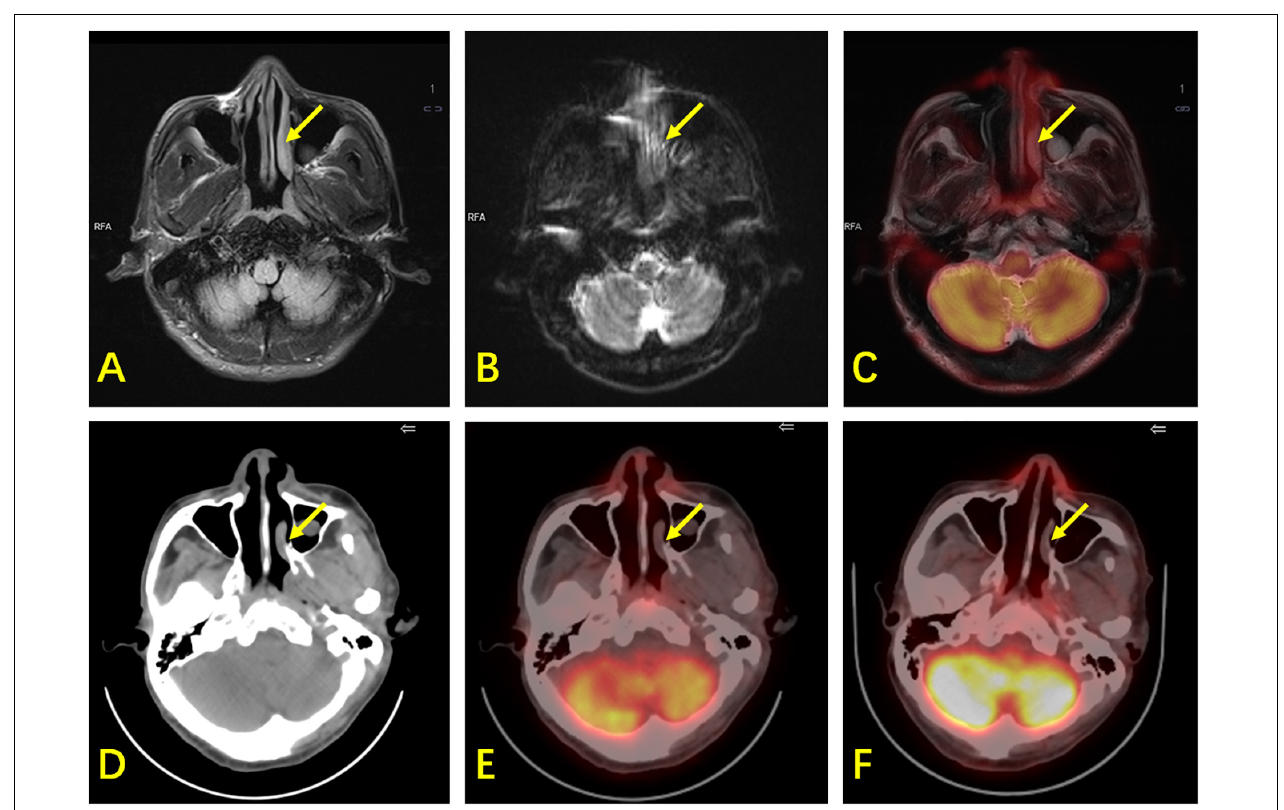
FIGURE 3 | A 61-year-old man with ENKTL. (A) T2WI shows mild thickening of the nasopharynx and left nasal cavity mucosa (arrow) with hyperintensity. (B) DWI shows limited diffusion of the lesion. (C) PET/MR shows mild 18 F-FDG uptake (SUVmax is 2.6, while the SUVmax of the reference liver is 2.3) and hyperintensity of T2WI of the lesion with suspected malignancy. (D) CT shows mild thickening of the nasopharynx and left nasal cavity mucosa. (E) 18 F-FDG PET/CT shows mild 18 F-FDG uptake in the nasopharynx (SUVmax is 1.9, while the SUVmax of the reference liver is 2.4), suspected as physiological. (F) There was still mild 18 F-FDG uptake in the nasopharynx during follow-up. The patient did not show any sign of relapse after 42 months. This lesion was confirmed to be physiological in terms of its uptake, and was false-positive by PET/MR.